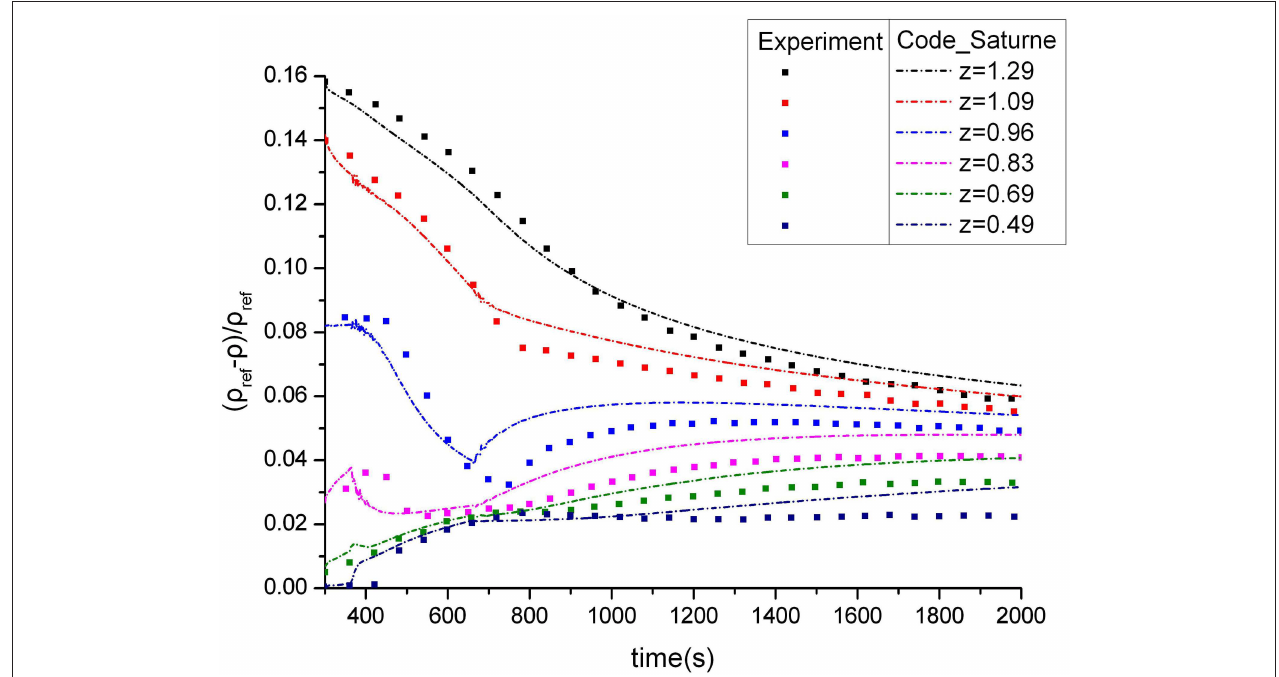
FIGURE 5 | Density comparison (Fr =